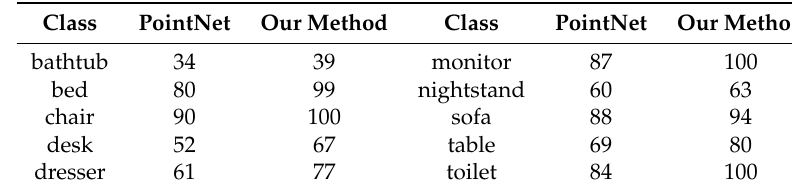
Table 4. The accuracy of each class in dataset: ModelNet10.